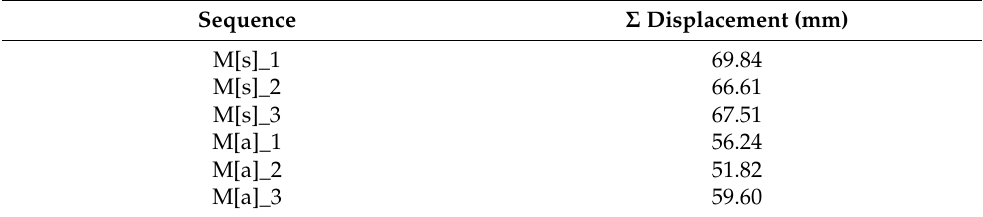
Table 3. Summation of the sample distortions in multipass welding.